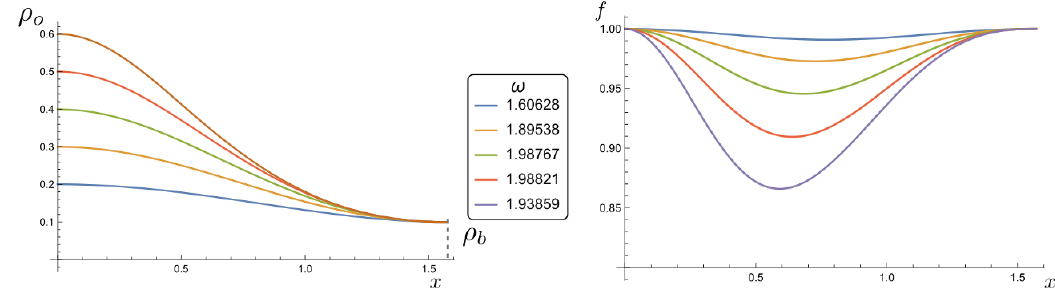
Figure 1 . Set of pro(cid:12)les for a range of values of ! b holding (cid:26) b = j (cid:30) ( (cid:25)= 2) j